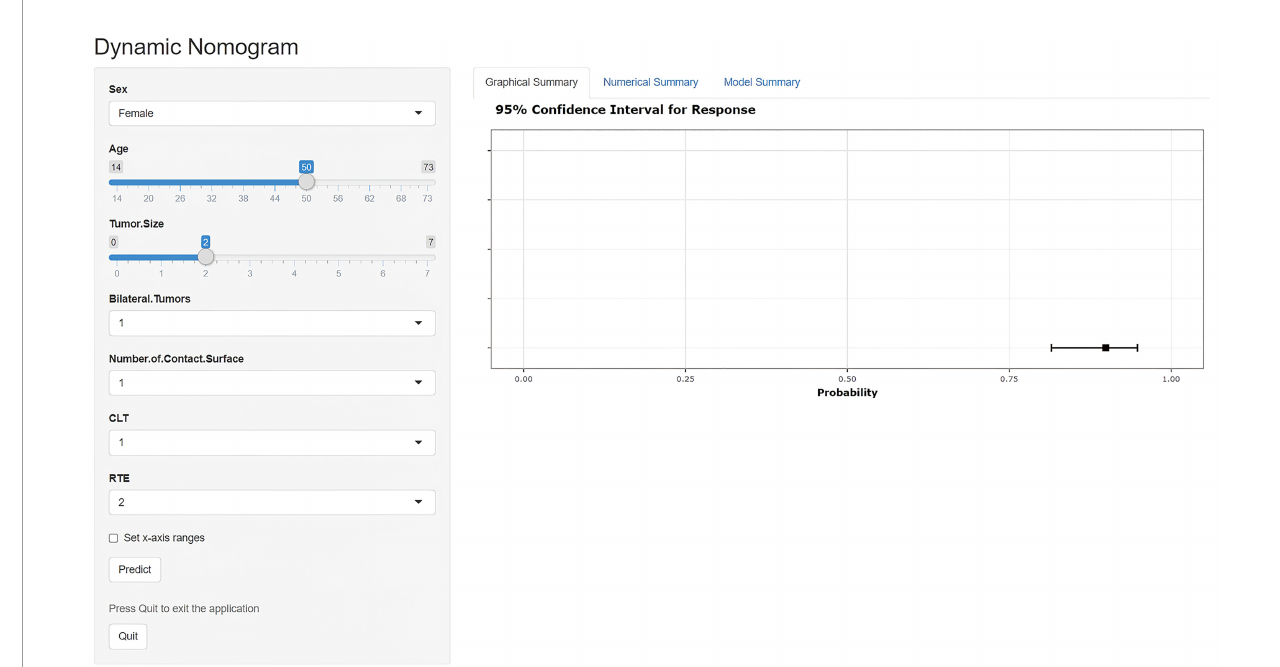
FIGURE 7 | Screen shot of the dynamic US-based nomogram used to predict central lymph node metastasis in cN0 papillary thyroid carcinoma (https://